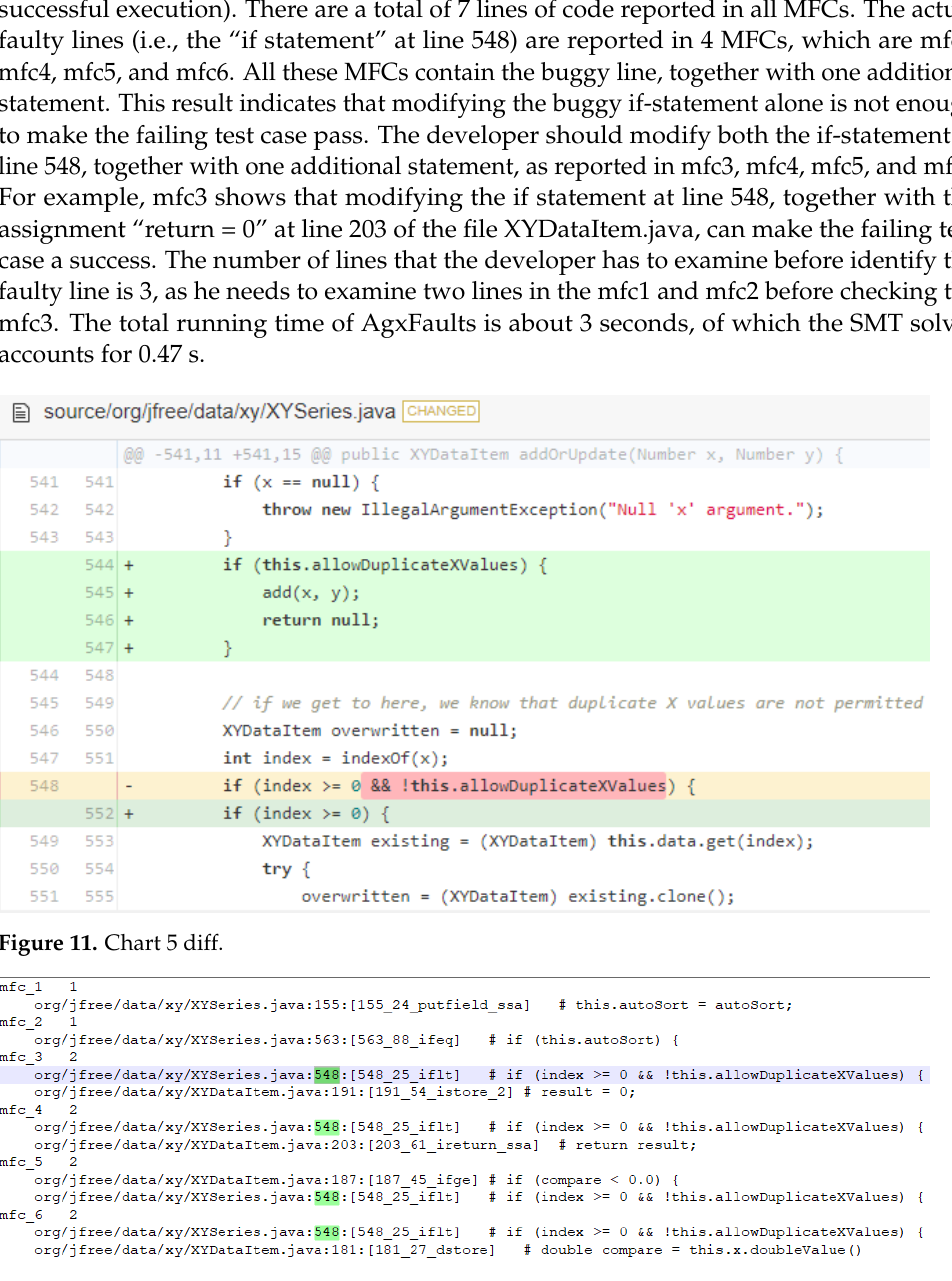
Figure 12. Minimal angelic fix candidates (MFCs) returned by AgxFaults for the bug Chart